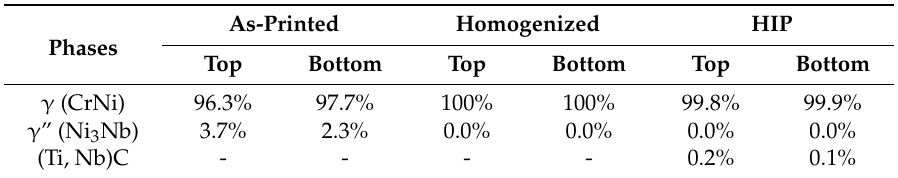
Table 2. Volume % of phases obtained by Rietveld analysis on XRD spectra from the top and bottom horizontal cross-sections of as-printed, homogenized, and HIPed